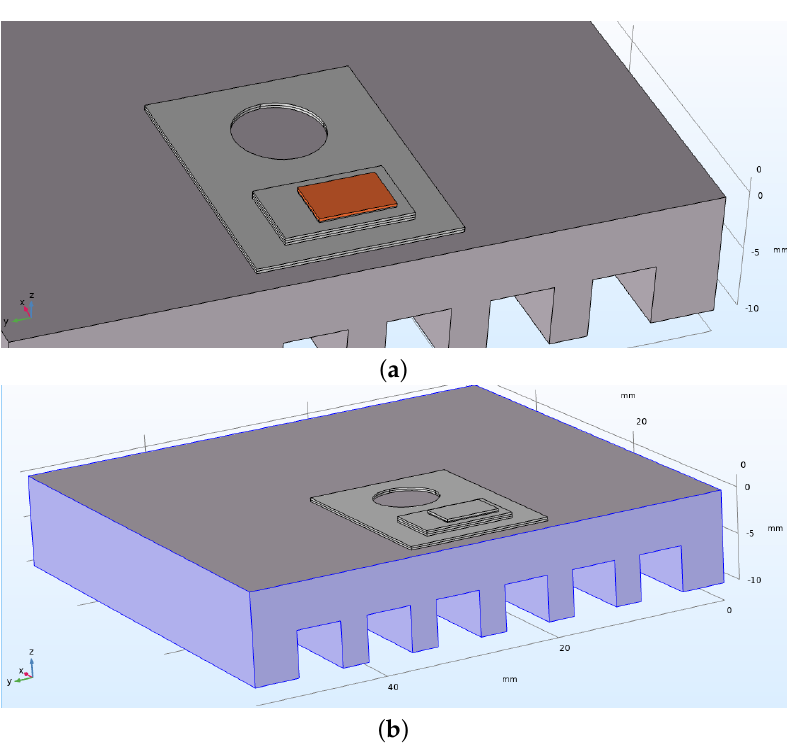
Figure 13. ( a ) Heat source in the chip area (red color), and ( b ) heat flux on the bottom area of the heatsink (blue area), as the main considered boundary